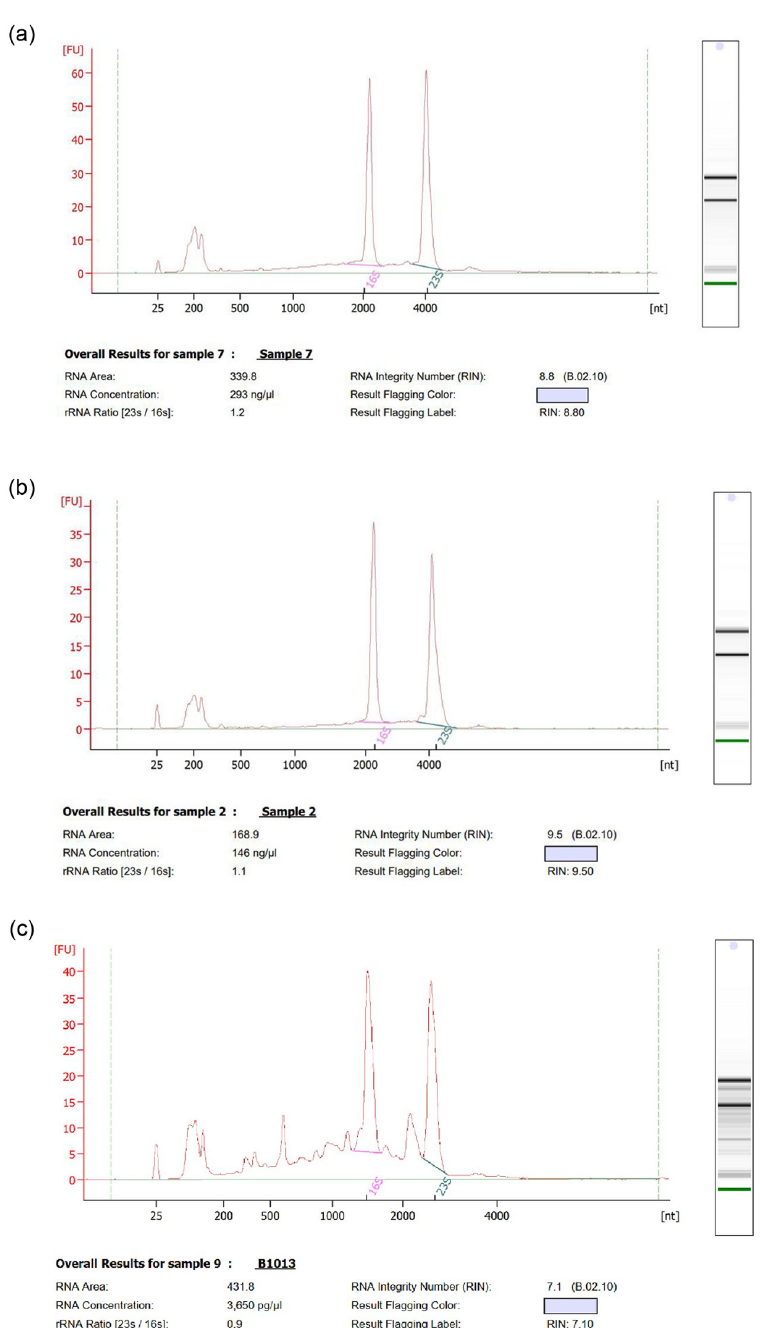
Fig 2. Bioanalyzer results. Electropherograms of total RNA extracted from Pseudomonas capeferrum TDA1 grown on: A) phenol (with TriFast method), B) phenol (with modified RNAzol RT method) and C) 2,4-TDA (with modified RNAzol RT method). The main peaks correspond to ribosomal RNA (16S and 23S).